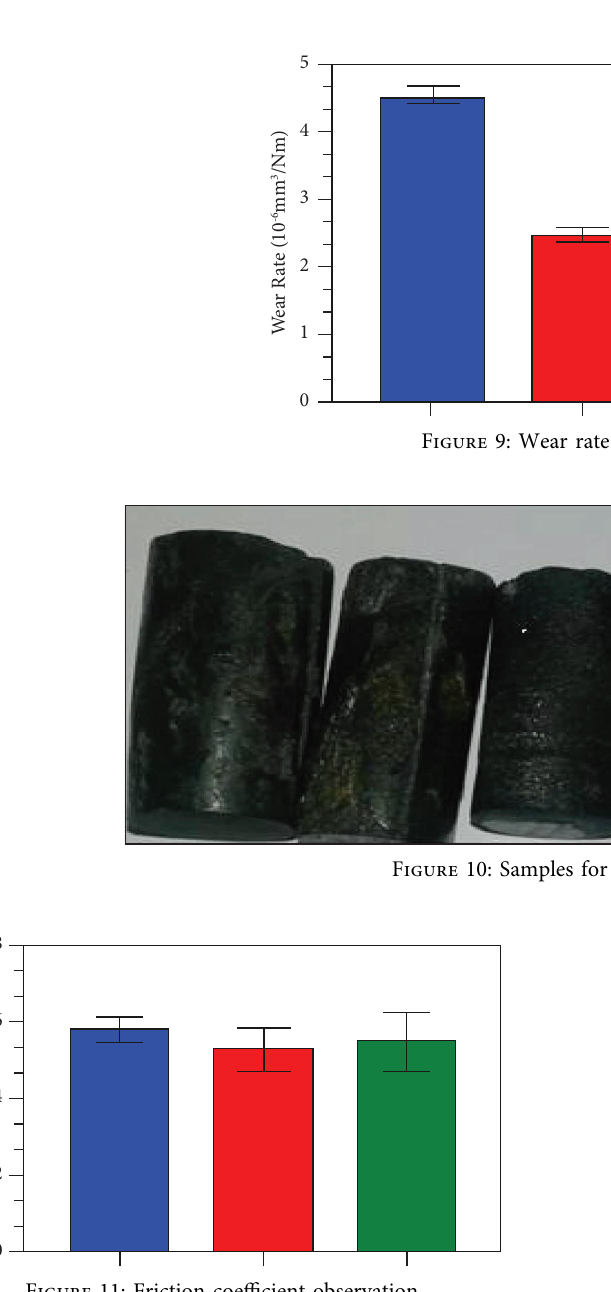
Figure 12: Pin on disc